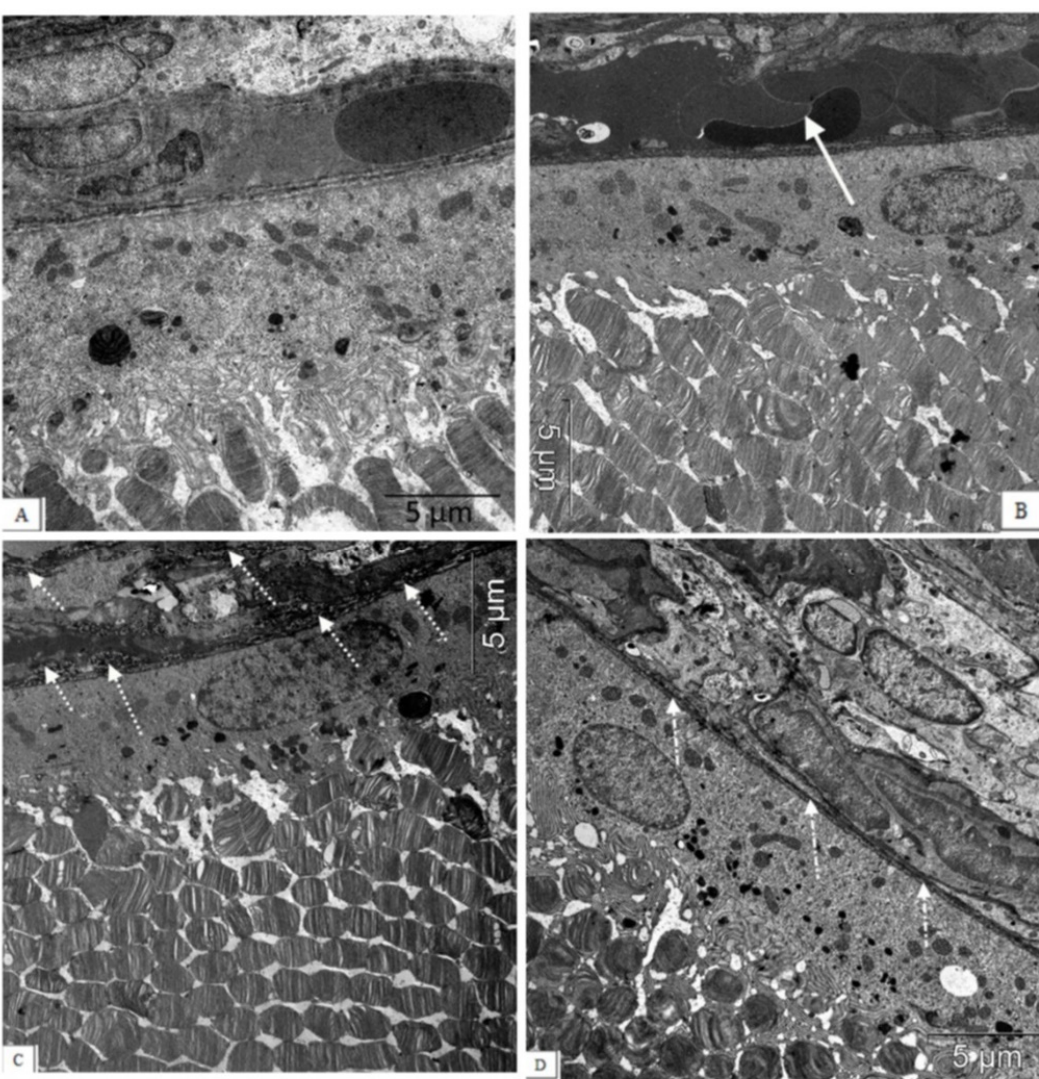
Figure 4. The electron micrographs show examples of normal ultrastructural features of the chori- oretinal complex of a Wistar rat ( A ), untreated ( B , C ) and an IQ-1S-treated ( D ) OXYS rat. Stasis, sludge of the blood vessels of the OXYS rat’s choroid (white arrow), destructive changes in the structure of the Bruch’s membrane, and capillary endothelium (dashed arrow) are presented. During treatment with IQ-1S, the structure of the Bruch’s membrane was intact, however, its thinning and increased osmiophilia were sometimes observed (( D ), white dot-dotted